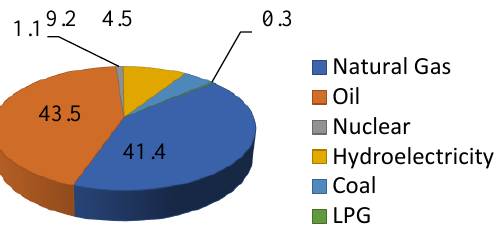
Fig. 2. Primary energy mix of Pakistan in year 2017-2021